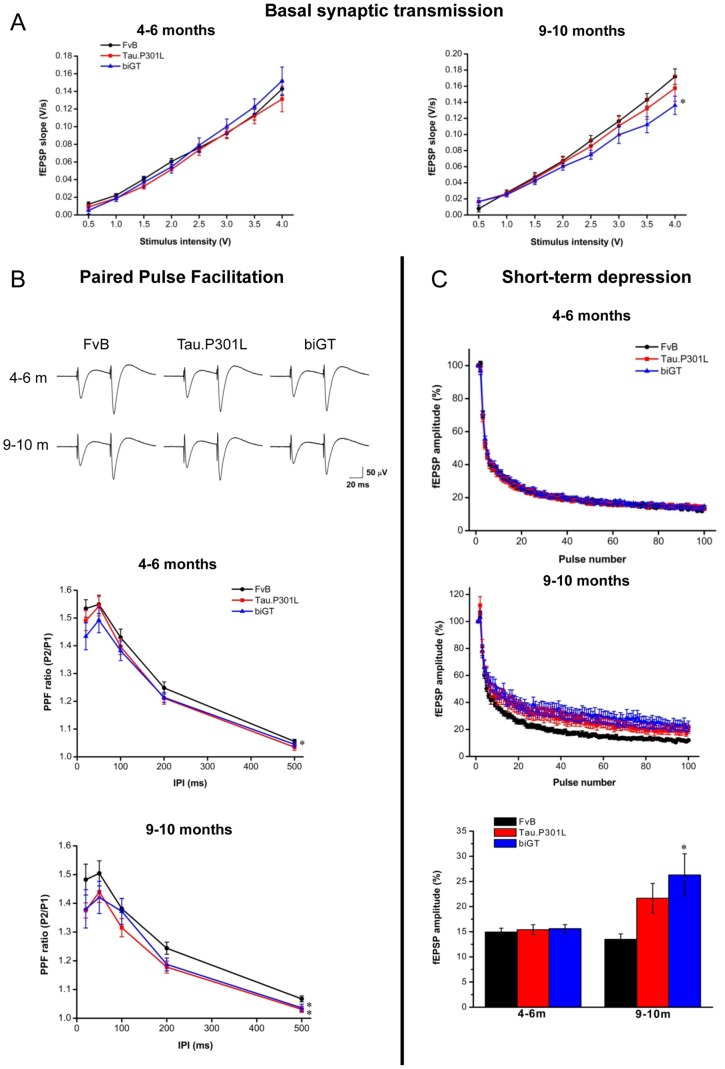
Electrophysiological analysis of SLM synapses in Tau.P301L and biGT mice.A. Basal synaptic transmission measured as the initial slope of fEPSPs in response to increasing stimulus intensities in young (left panel) and old mice (right panel). Old biGT mice differed significantly from wild-type FvB mice: *p = 0.005. B. Paired-pulse facilitation are expressed as amplitude ratio of second to first peak. Tracings are averaged at 50 ms IPI in young and old FvB, Tau.P301L and biGT mice. Statistical analysis at 4–6 months: *p = 0.021 biGT vs FvB; at 9–10 months: *p = 0.039 biGT vs FvB and p = 0.004 Tau.P301L vs FvB.